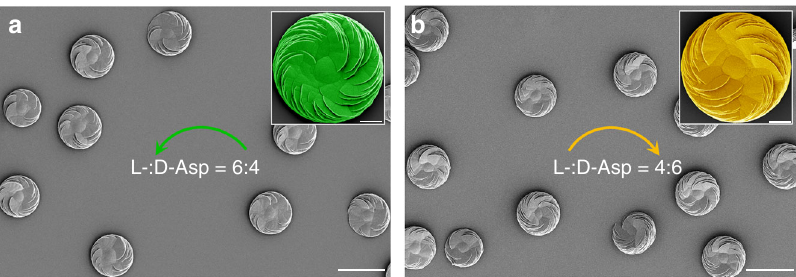
Fig. 1 Homochiral vaterite helicoids induced in the presence of nonracemic mixtures of L - and D -enantiomers of amino acid. SEM images of chiral vaterite helicoids after 2 days growth in the presence of 20 m M total Asp enantiomer mixture consisting of 12 m M L -Asp and 8 m M D -Asp (6:4 ratio, e.e. L = 20%), showing identical counterclockwise orientation of vaterite platelets (green arrow, a ). Conversely, 8 m M L -Asp and 12 m M D -Asp (4:6 ratio, e.e. L = − 20%) produces identical clockwise orientation of the platelets (yellow arrow, b ). Insets: pseudocolored single chiral vaterite helicoids at higher magni fi cation for